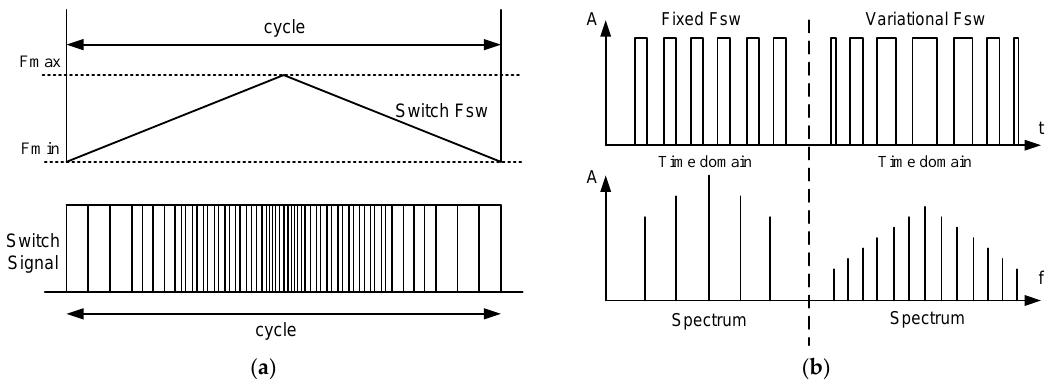
Figure 2. Frequency swapping technique and EMI suppression principle: ( a ) principle of switching frequency swapping; ( b ) fixed-frequency and variable-frequency signal spectra.